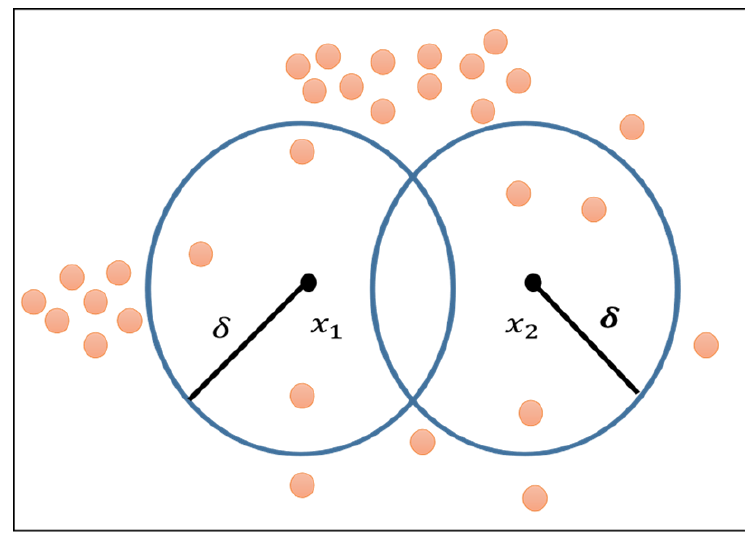
Figure 9. k th nearest neighbors when k = 3.